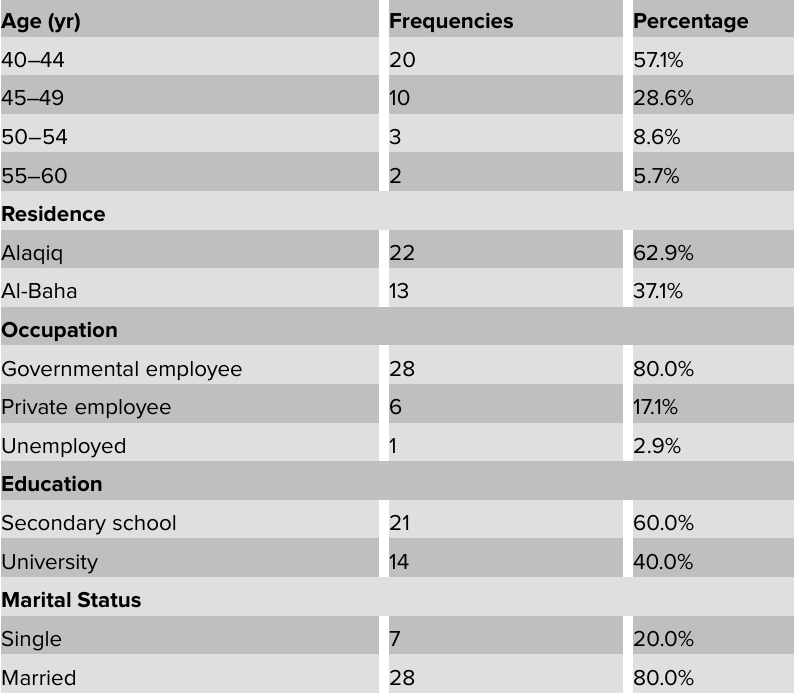
Table 1: Demographic characteristics of women at Al-Baha region, n = 35.